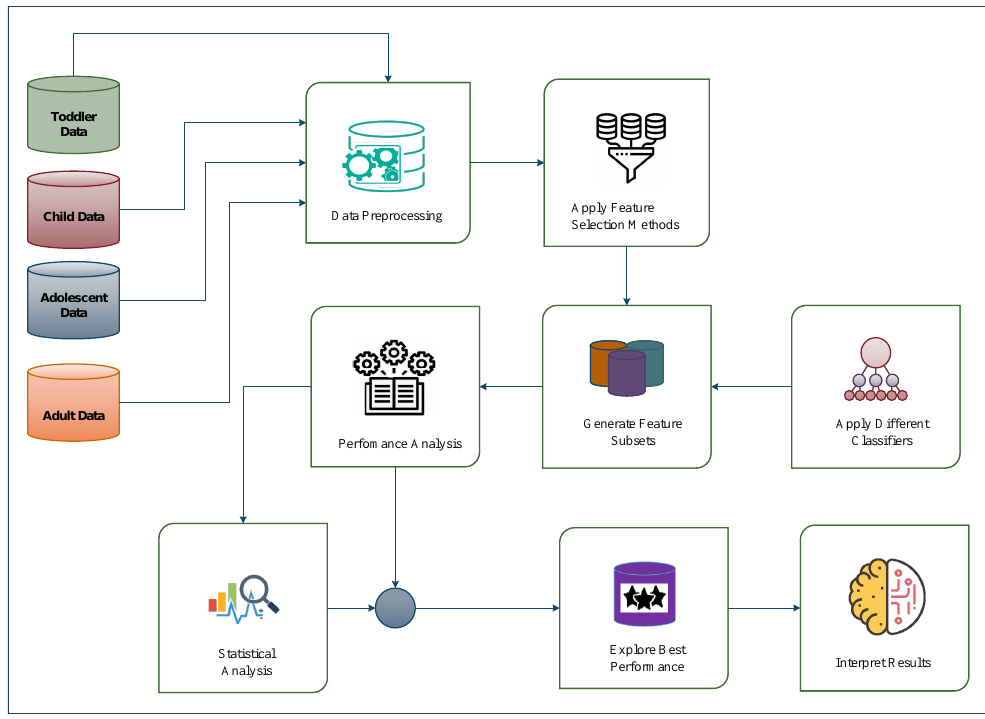
Figure 1. The proposed framework for early ASD